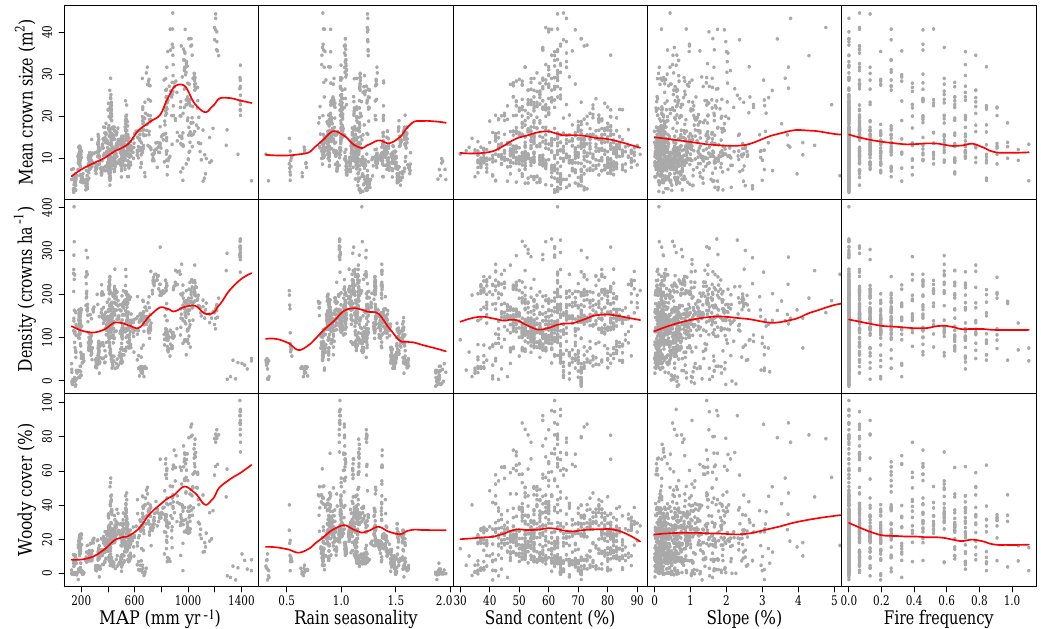
Figure 7. Modeled BRT responses (“partial dependencies”) of woody canopy properties to each environmental variable when accounting for the average effect of the other four variables. The red lines are smoothed representations of the responses, with fitted values (model predictions based on the original data) for each of the 876 sites shown as grey dots. The x axis for the slope predictor was truncated at 5% to highlight the response in the bulk of the data.